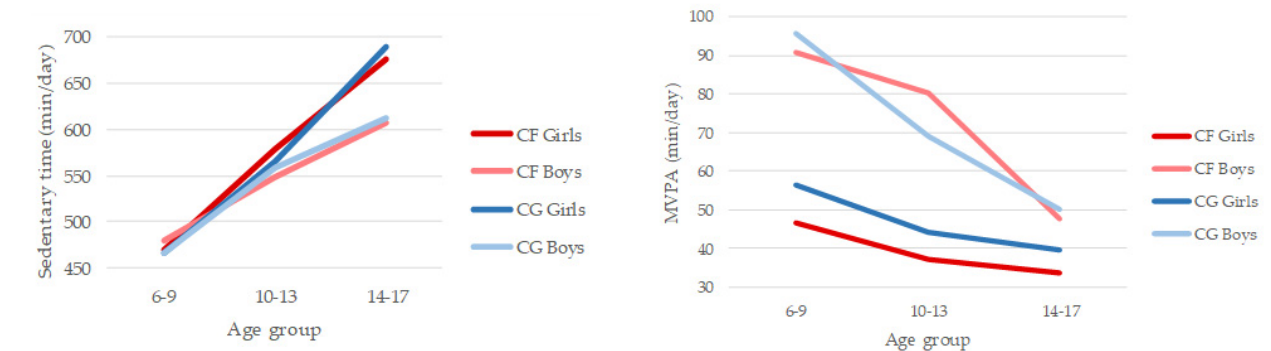
Figure 1. Patterns of daily sedentary behaviour and moderate-to-vigorous physical activity compared between cystic fibrosis (CF) and control group (CG) by gender and age group.